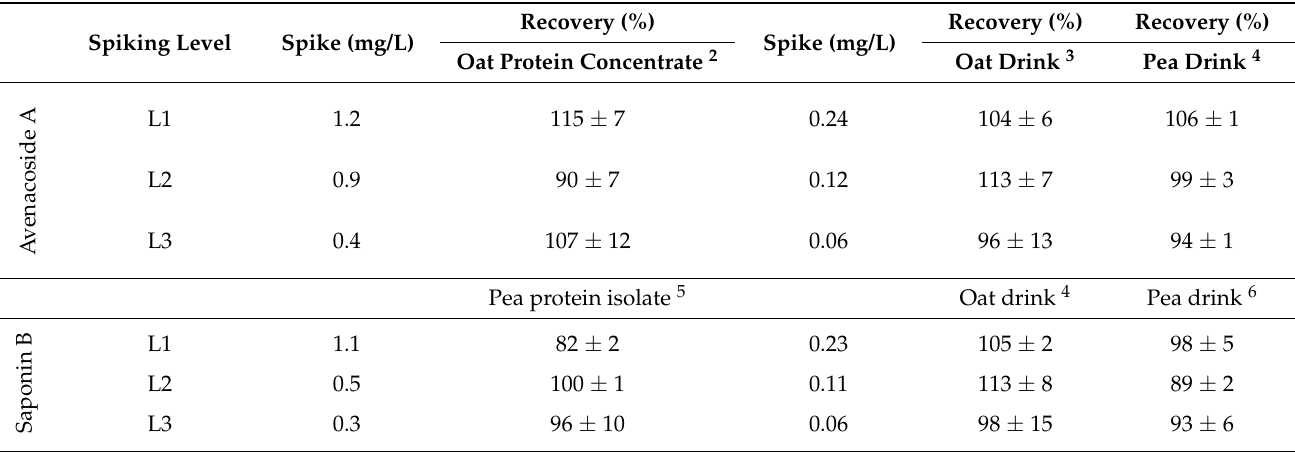
Table 4. Recoveries of saponins in solid (oat protein concentrate and pea protein isolate) and liquid samples (oat drink and pea drink) 1